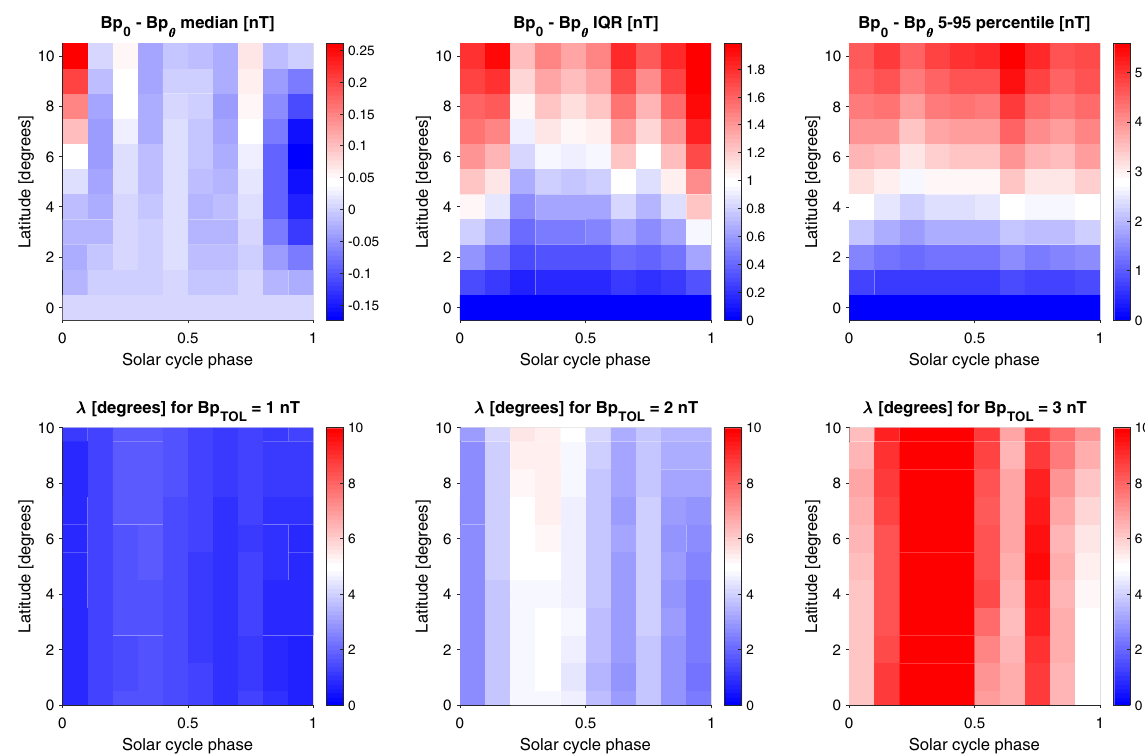
Fig. 11. Summary plots for the poloidal HMF component, B p , in the same format as Figure